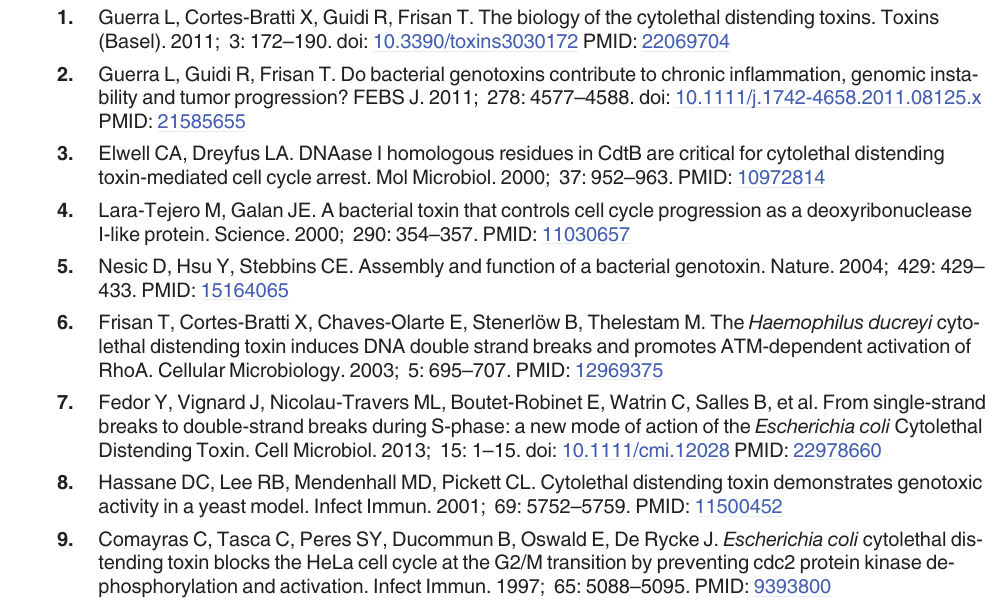
S1 Fig. Ionizing radiation promotes integrin β 1 activation. HeLa cells were seeded and fur- ther left untreated (CTR, dotted line), irradiated with 8 Gy (IR, black line) and further incubat- ed in complete medium for 6h, or intoxicated with CDT (1 μ g/ml) for 6h (grey line). Surface expression of the integrin β 1 total levels (left panel) or its activate form (right panel) was as- sessed by FACS analysis as described in Material and Methods. S2 Fig. Effect of the KU-55933 inhibitor on the activation of the DNA damage response. HeLa cells were exposed to increasing concentration of the ATM inhibitor KU-55933 (ATMi) for 1h prior intoxication with CDT (1 μ g/ml). The levels of phosphorylation of the ATM sub- strates CHK2 and H2AX were assessed by Western blot analysis 6h post-intoxication. (TIF) S3 Fig. siRNA knock down. HeLa cells were transfected with the non-silencing siRNA (scRNA), or the specific siRNA for NET1 ( A ), ALIX ( B ) or TSG101 ( C ). The levels of expres- sion of the endogenous proteins were analyzed by western blot 48h after transfection. Actin ex- pression was assayed as loading control. The figure shows a representative Western-blot analysis, and the quantification of three independent experiments (mean ± SEM). The data are presented as the ratio of the optical intensity (OD) of the specific band in cells transfected with the indicated siRNA and the optical intensity of the specific band in cells transfected with the control